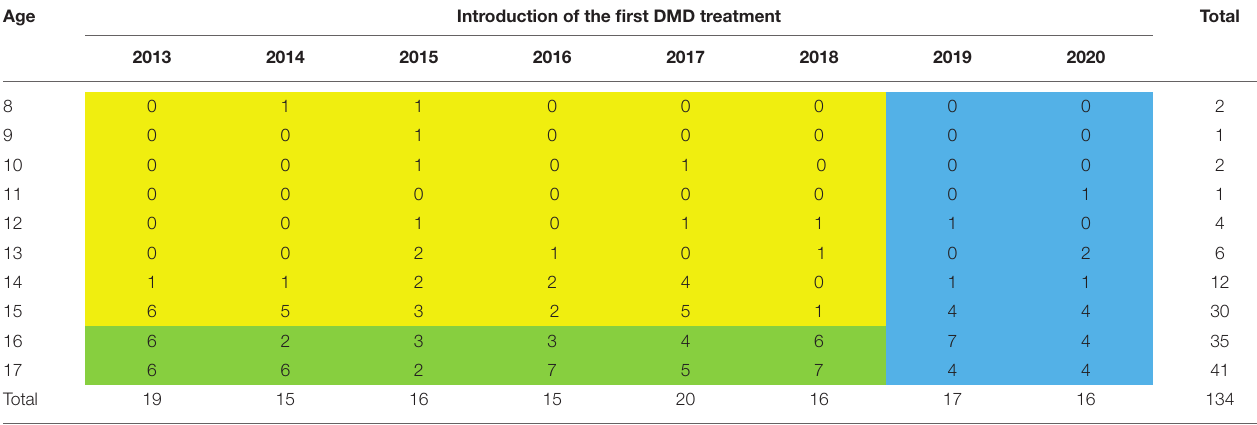
TABLE 1 | Demographic characteristics of the pediatric population at the time of the introduction of DMD treatment (by age and by year). Age Introduction of the first DMD treatment